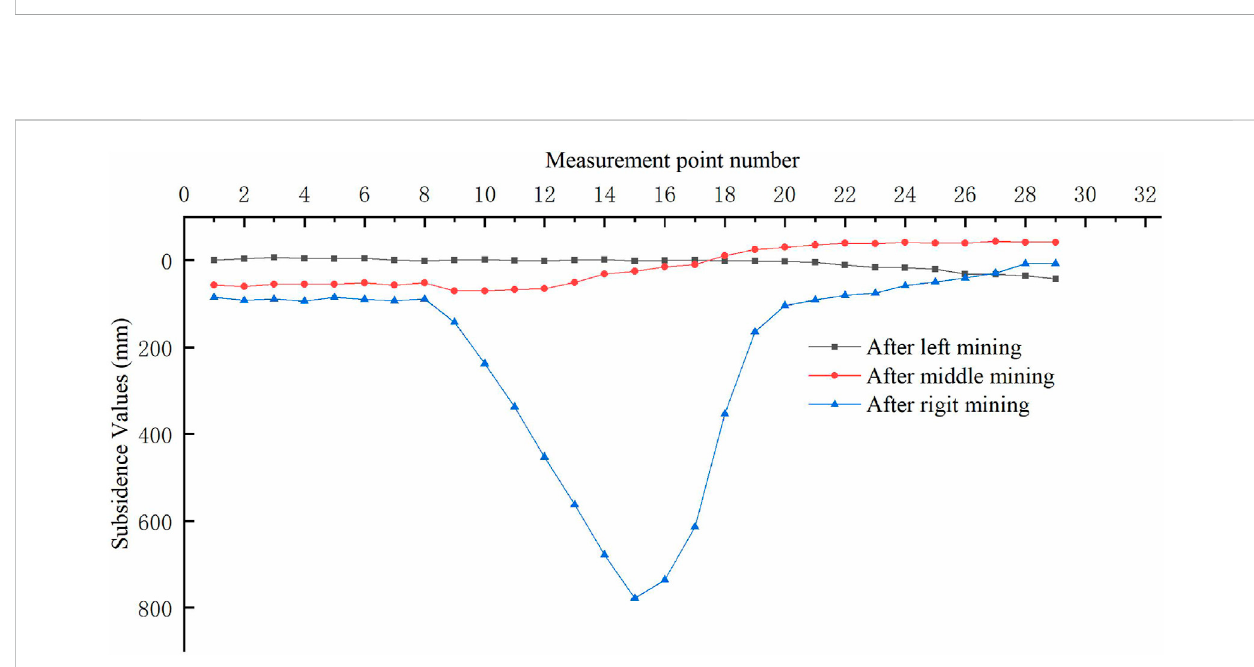
FIGURE 6 Surface subsidence curve during